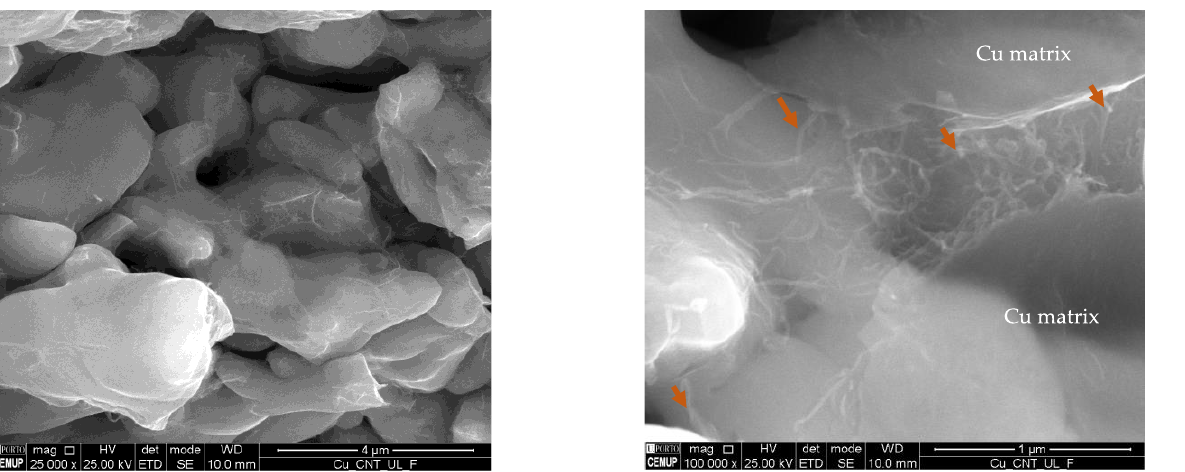
Figure 8. SEM image of the Cu/CNT fracture surface of the nanocomposites produced by ultrasoni- cation, where the arrows point to elongated and fractured CNTs.